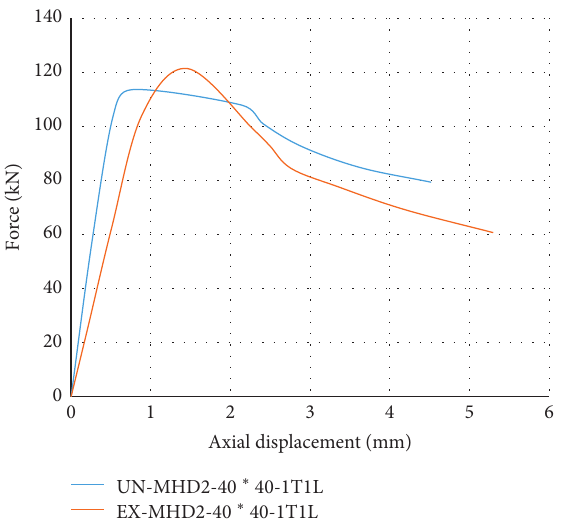
Figure 8: Force-displacement diagram of model and laboratory sample.